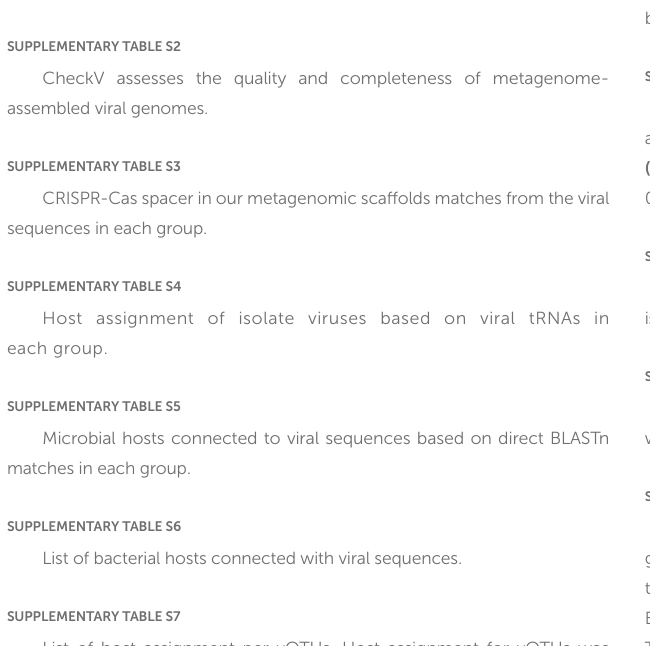
Strong (| ρ | > 0.7) and significant ( p < 0.01) correlations between vOTUs and bacterial hosts.